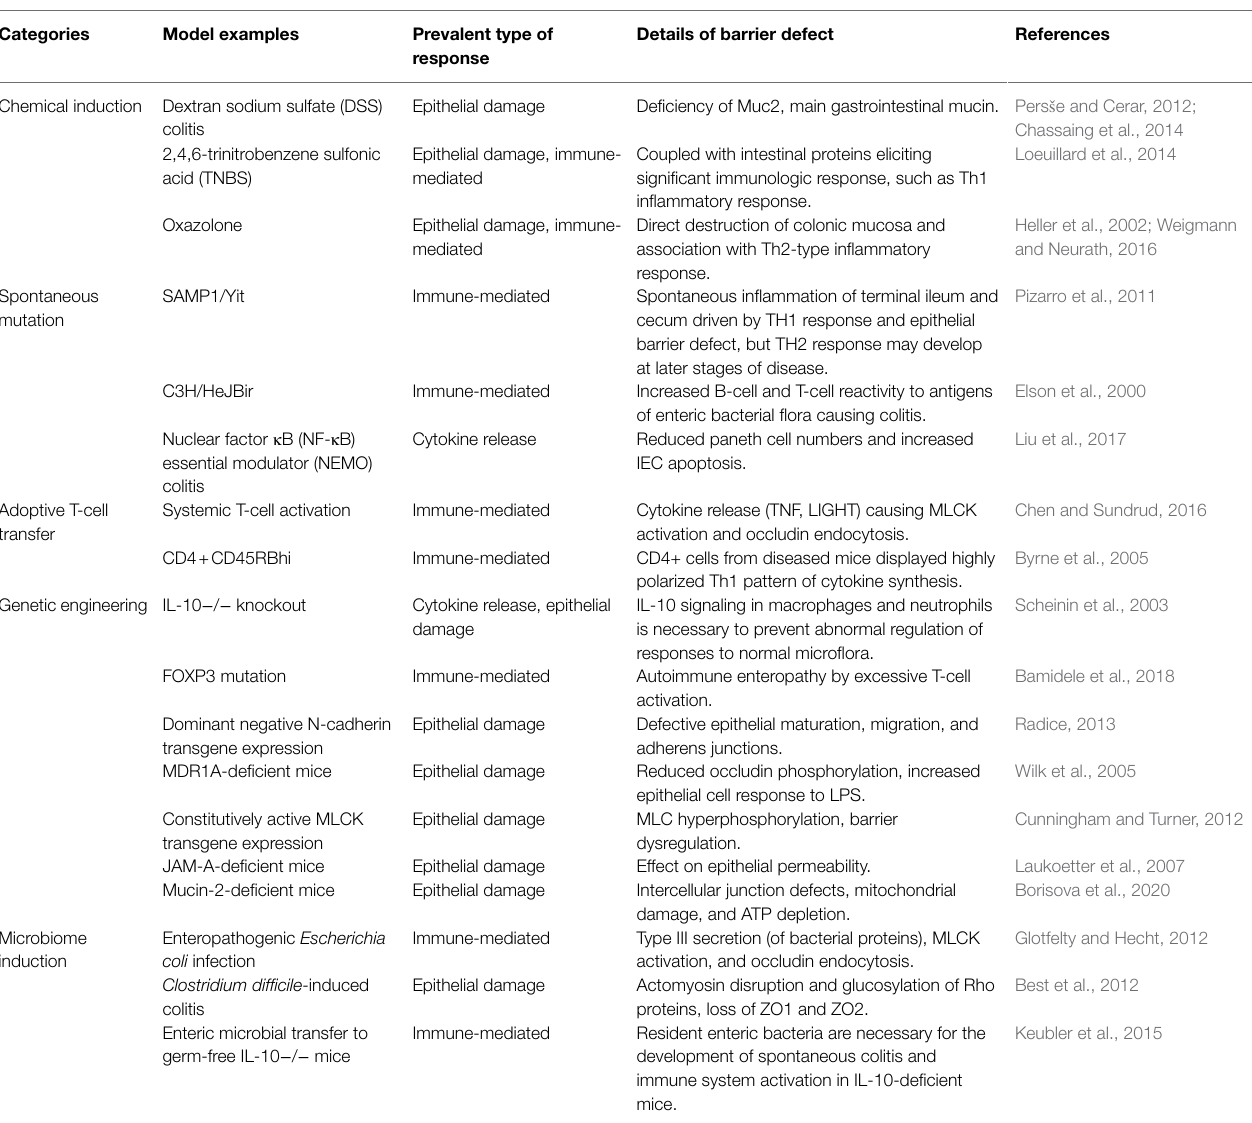
TABLE 2 | Commonly used IBD mouse